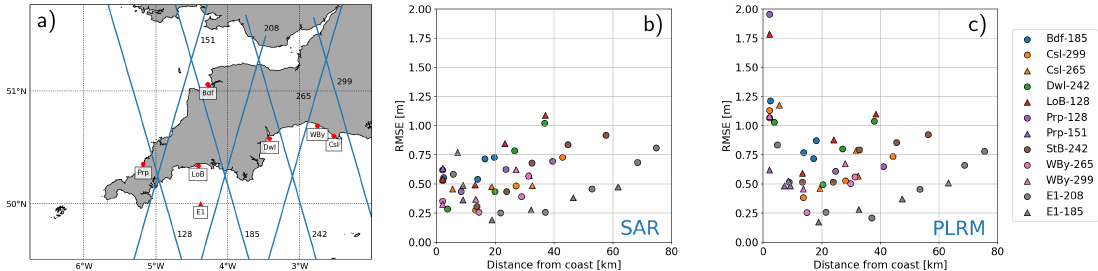
Figure 19. ( a ) Locations of the wave buoys and Sentinel-3A tracks around southwest UK used for the validation. Root mean square bias of S3A wave height and in situ coastal wave buoys observations as a function of distance to coast: ( b ) SAR mode ( c ) PLRM mode. (Each coloured symbol represents a different track-buoy comparison.). From Nencioli and Quartly